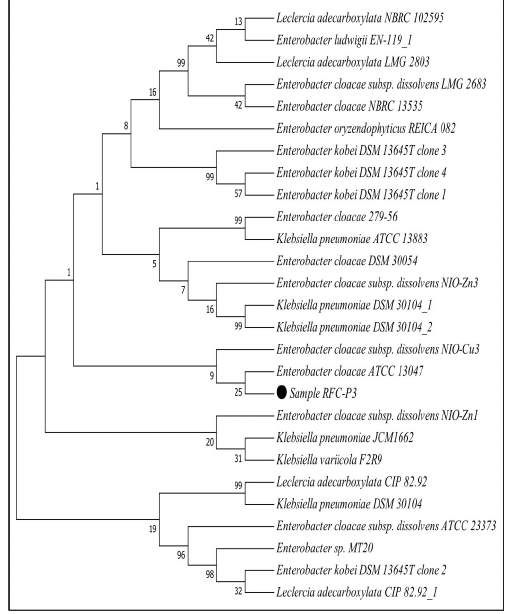
Fig. 3. Phylogenetic tree of